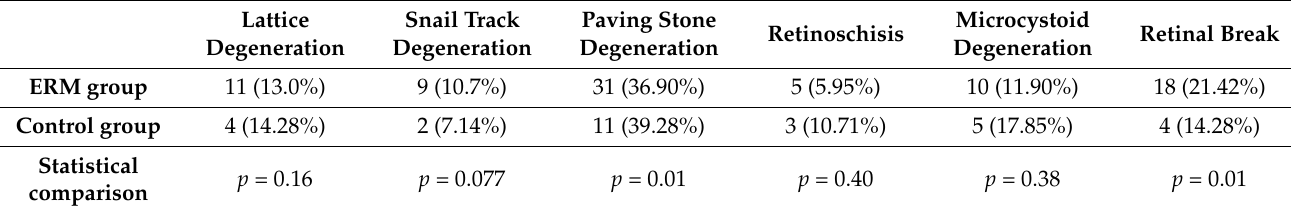
Table 2. Peripheral retinal changes in patients with epiretinal membrane and in the control group using UWF laser